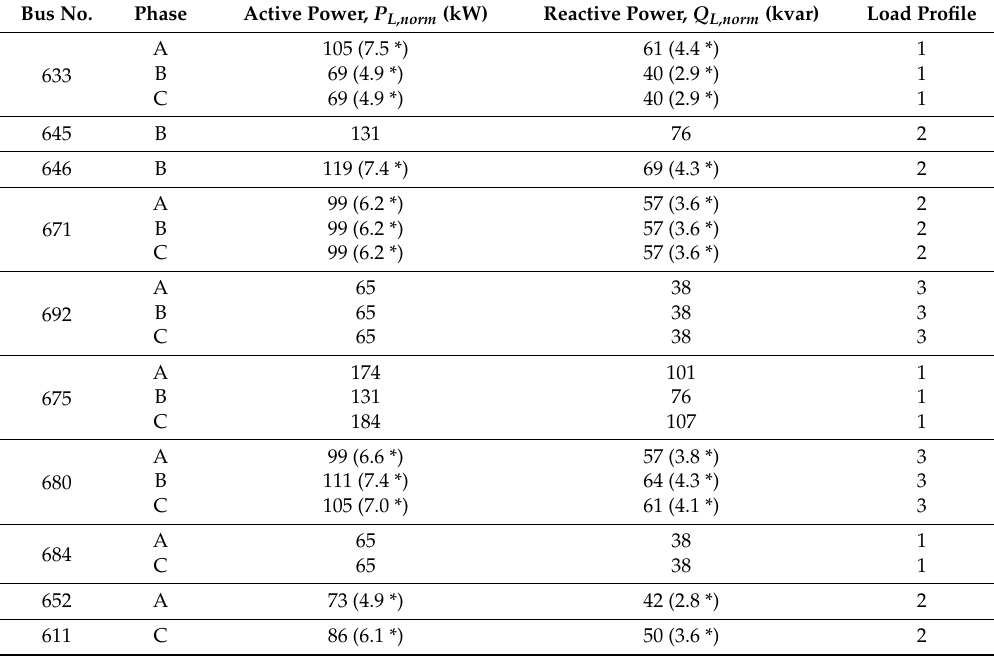
Table 3. Average load demand.